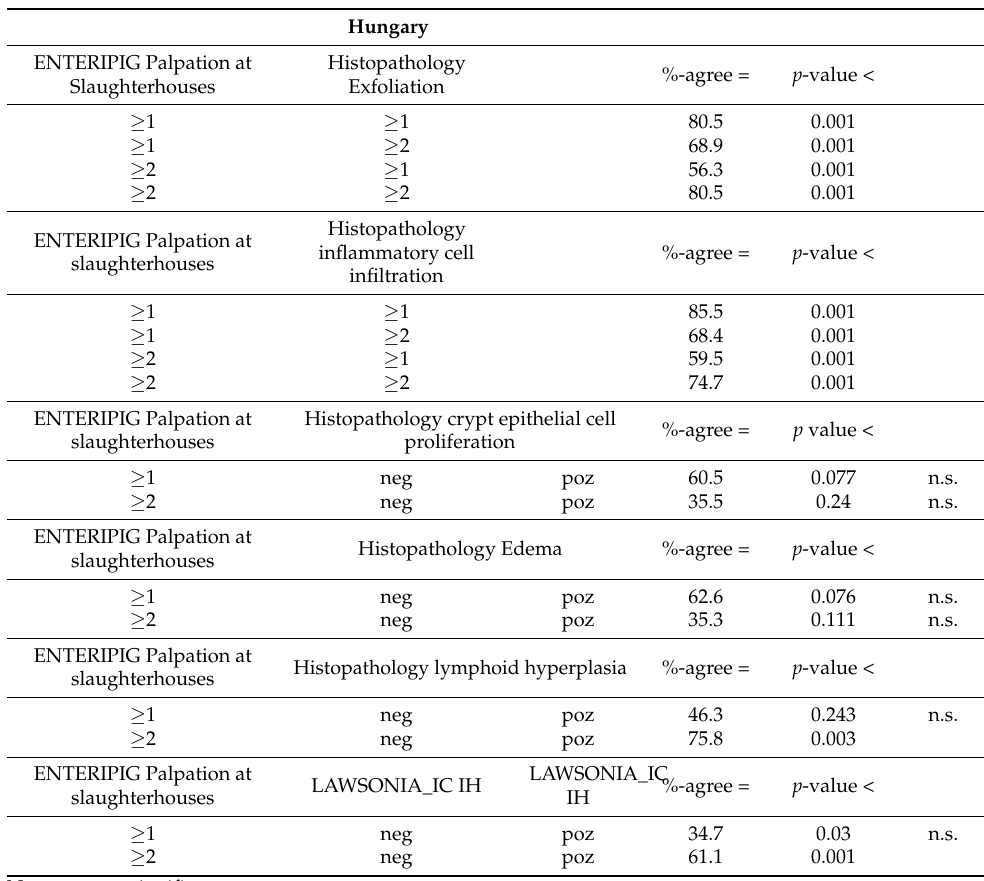
Table 5. Cohen’s analyses of VP and